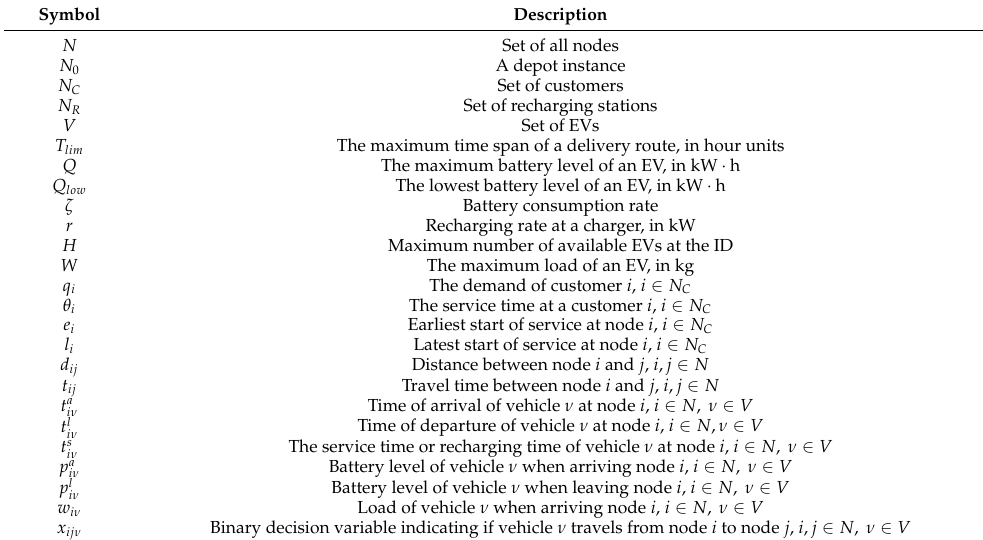
Table 2. List of notations in the E-VRP